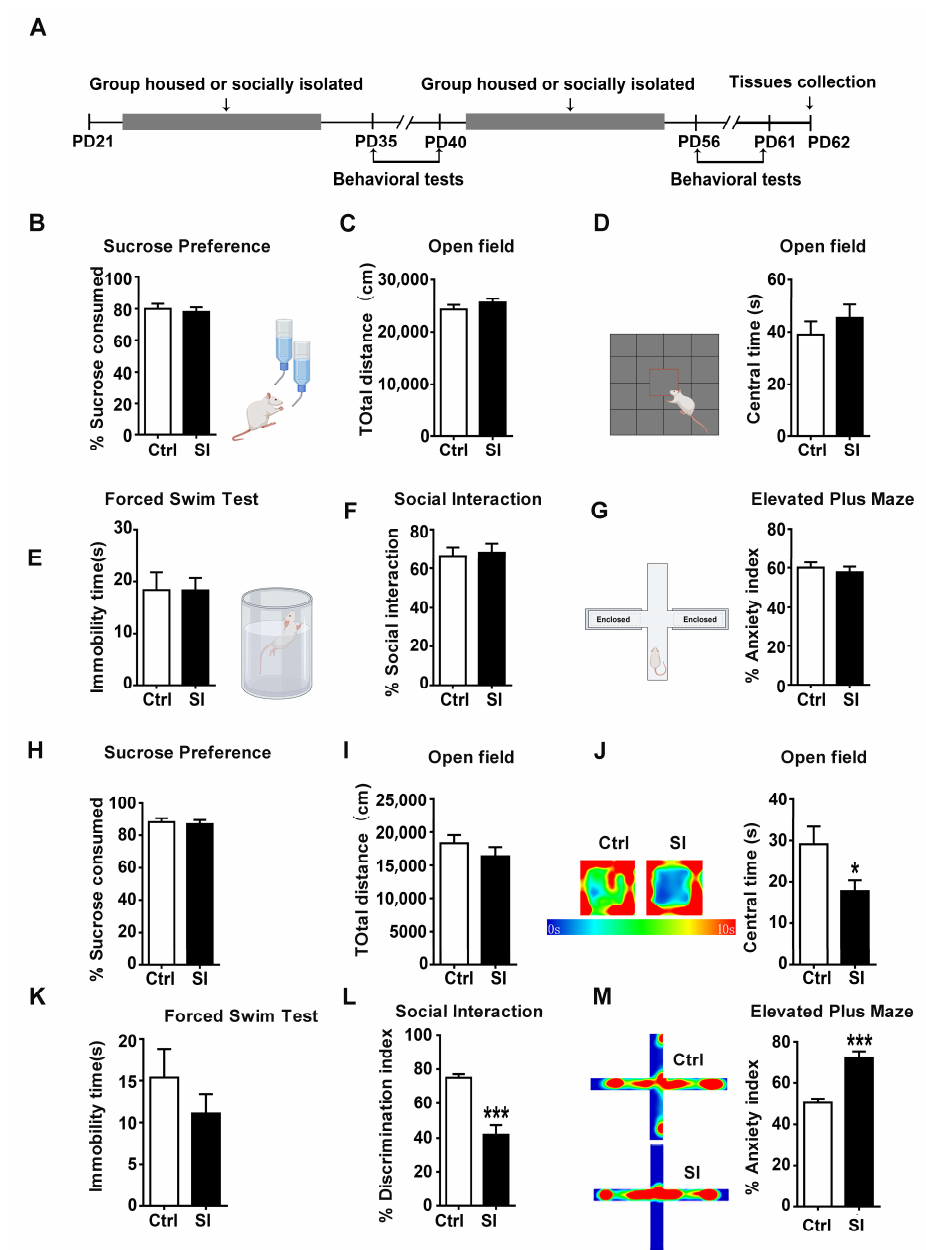
Figure 1. Social-isolation-induced anxiety-like behavior and social dysfunction but not depression- like behavior at late adolescence in female rats: ( A ) experimental paradigm for adolescent social isolation; ( B ) social isolation had no effect on the percentage of sucrose consumed at early adolescence; ( C , D ) in the open field test, adolescent social isolation had no effect on the total distance and time spent in the central area at early adolescence; ( E – G ) social isolation had no effect on the immobility time, the percentage of social interaction and the percentage of anxiety index at early adolescence; ( H ) social isolation had no effect on the percentage of sucrose consumed at late adolescence; ( I ) adolescent social isolation had no effect on the total distance at late adolescence; ( J ) the isolated rats showed less time in the middle of the open field at late adolescence; ( K ) social isolation had no effect on the immobility time at late adolescence; ( L ) the isolated rats exhibited decreased percentage of social interaction at late adolescence; ( M ) the isolated rats exhibited increased anxiety behavior as assessed by the percentage of anxiety index in the elevated plus maze at late adolescence; data were analysed using Student’s t-test and presented as mean ± SEM; *** p < 0.001 and * p < 0.05 com- pared to the isolated group; Ctrl indicates control; SI indicates social isolation.